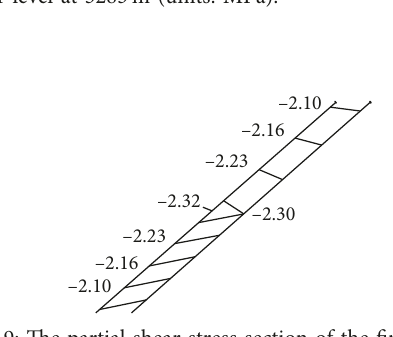
Figure 18: Shear stress in the concrete face under condition 3 with the water level at 3283m (units: MPa).